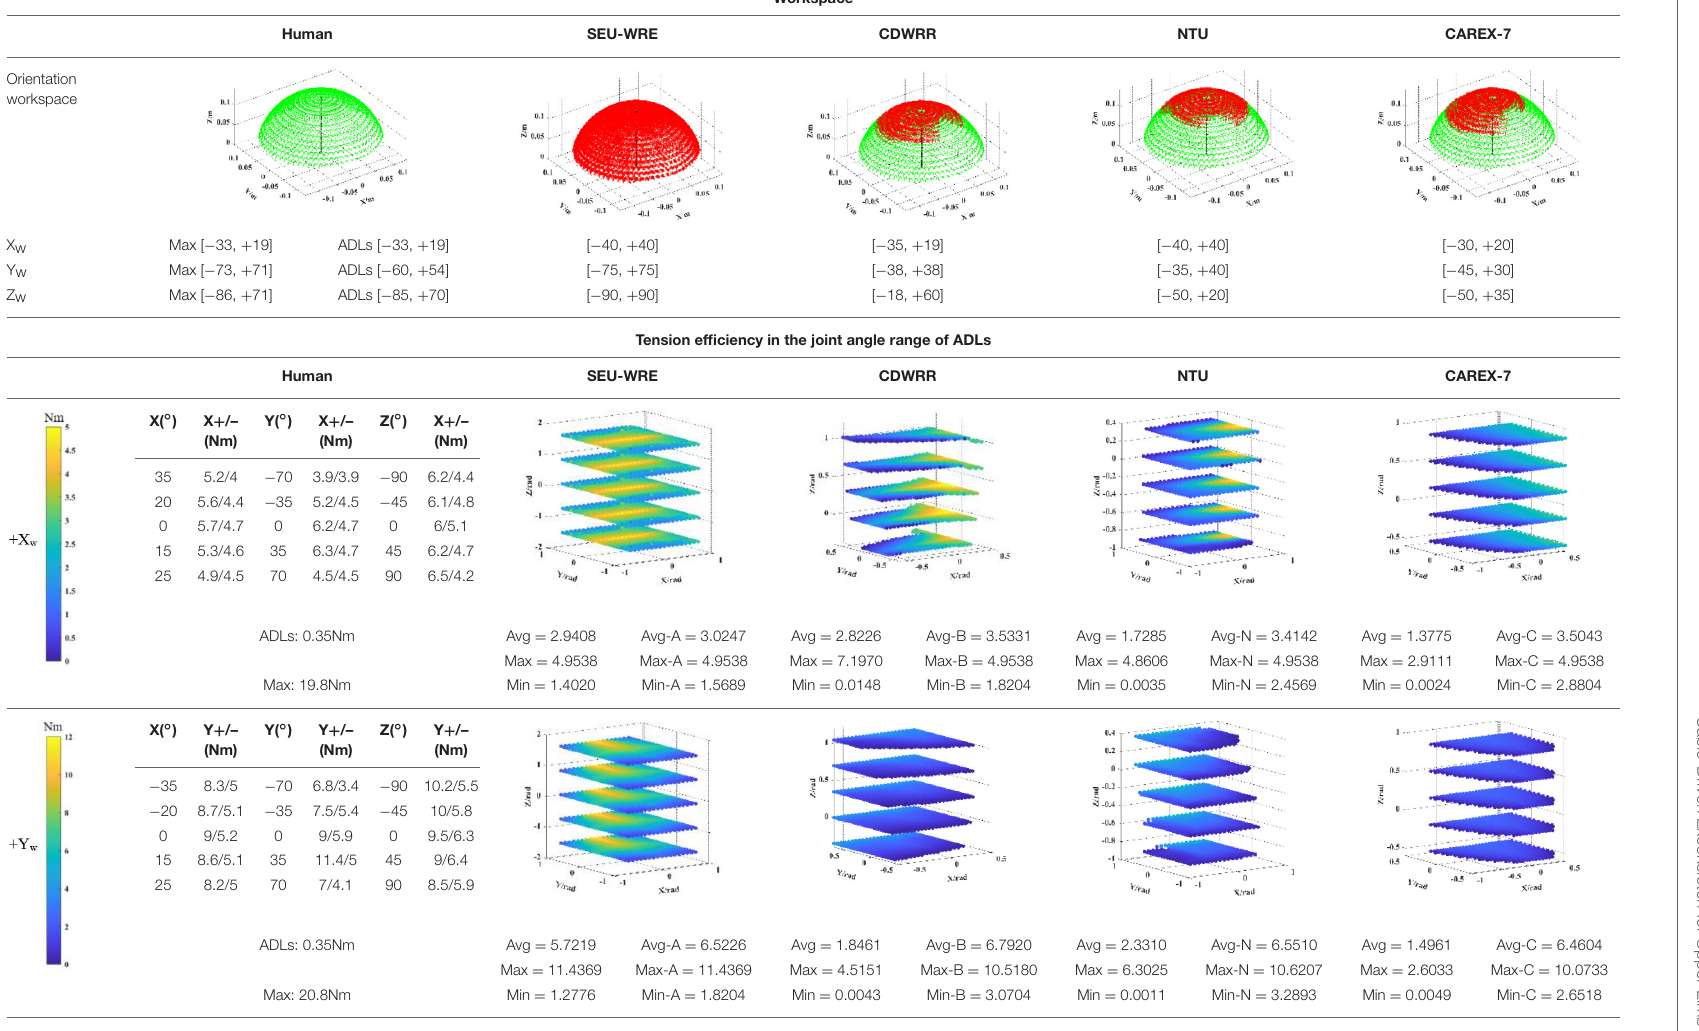
TABLE 3 | The workspace and tension efficiency comparison of four cable-driven robot. Workspace Human SEU-WRE CDWRR NTU CAREX-7 Orientation